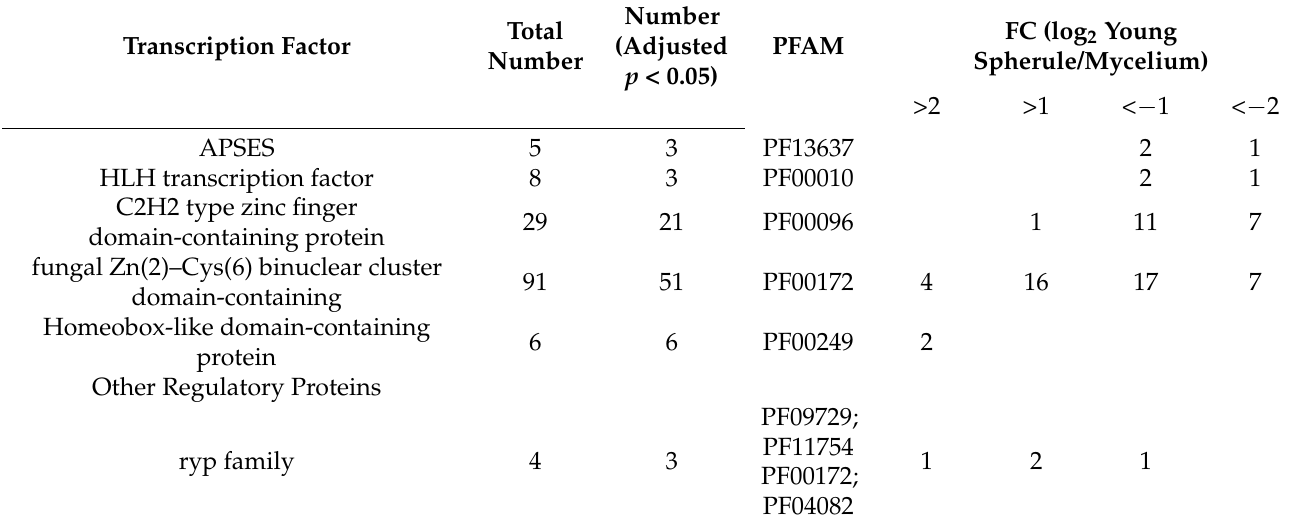
Table 3. Relative expression of transcription factors in young spherules and mycelia.